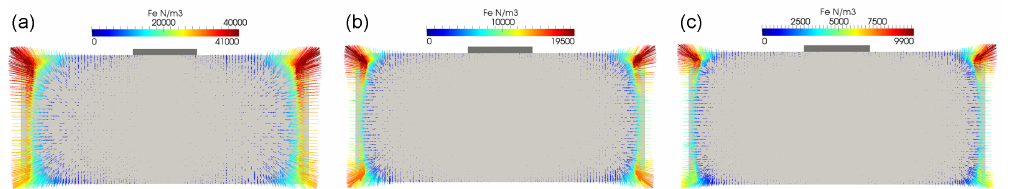
Figure 2. The thermal field in the furnace in the vertical plane ( y = 0) for ( a ) Case 1, ( b ) Case 2, and ( c ) Case 3.